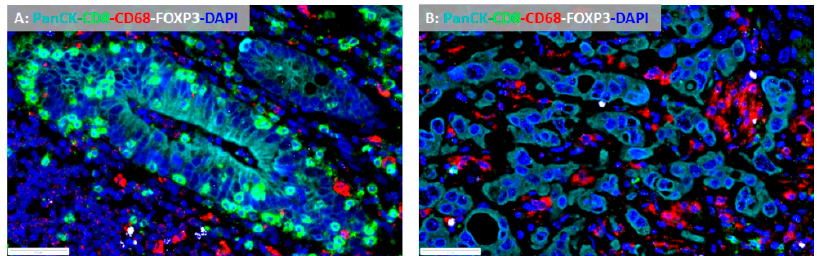
Figure 1. ( A ): Pancreatic cancer from a long-term survivor (i.e., overall survival > 60 months) with a «hot» tumor microenvironment, dominated by CD8 + cytotoxic tumor infiltrating lymphocytes (multiplex immunofluorescence × 400); ( B ): pancreatic cancer from a short-term survivor (overall survival < 12 months) with an immunosuppressive tumor microenvironment poor in CD68 + tumor infiltrating lymphocytes and dominated by CD68 + tumor associated macrophages and FOXP3 + T regulatory cells (multiplex immunofluorescence × 400).